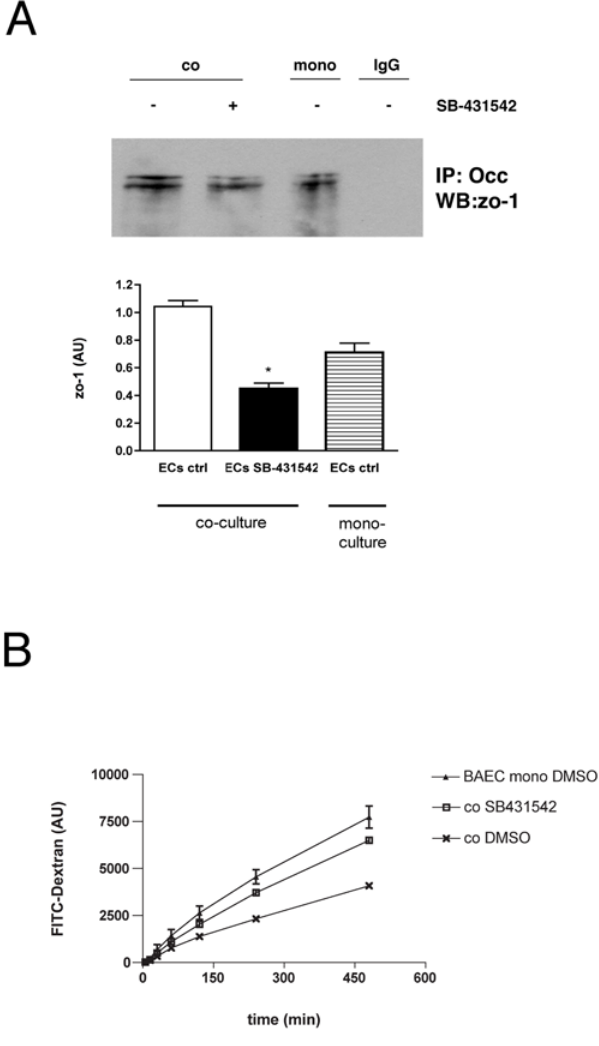
Figure 6. Inhibition of TGF- b impairs endothelial tight junction protein association. (A) Assay of tight junction components in Transwell cocultures of EC and 10T1/2 cells. Immunoprecipitation of occludin and western blotting for zo-1 revealed a significant increase in association between occludin and zo-1 in coculture compared to monocultures (* p , 0.05), which was reversed by the addition of SB- 431542. Non-specific IgG was used as a control for IP. (B) Assay of permeability in Transwell cocultures. Coculture of BAECs with 10T1/2 cells increased EC barrier function as measured by decreased flux of FITC-dextran from the upper to lower chamber. Addition of SB-431542 increased permeability of BAEC/10T1/2 cocultures.